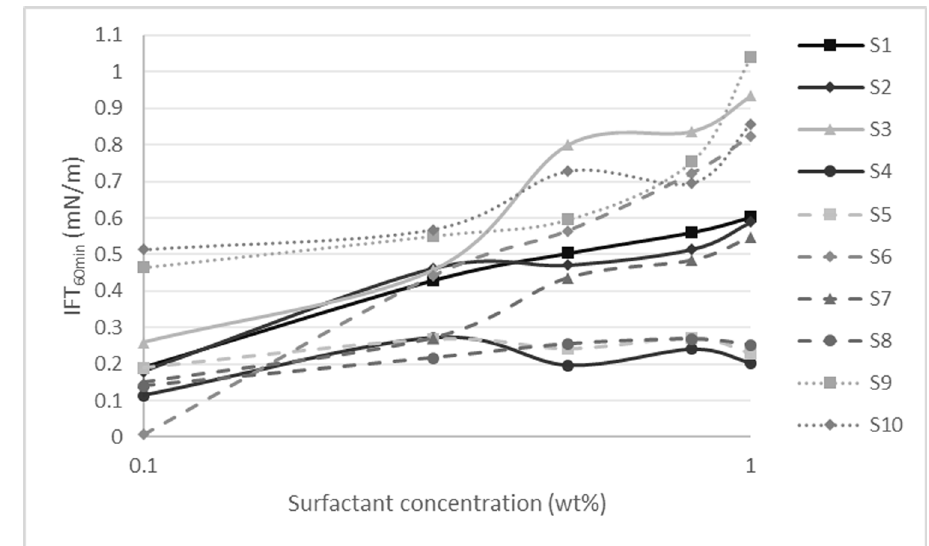
Figure 7: IFT results for surfactant ‒ brine ‒ oil at reservoir temperature and a concentration range of 0.1 – 1.0